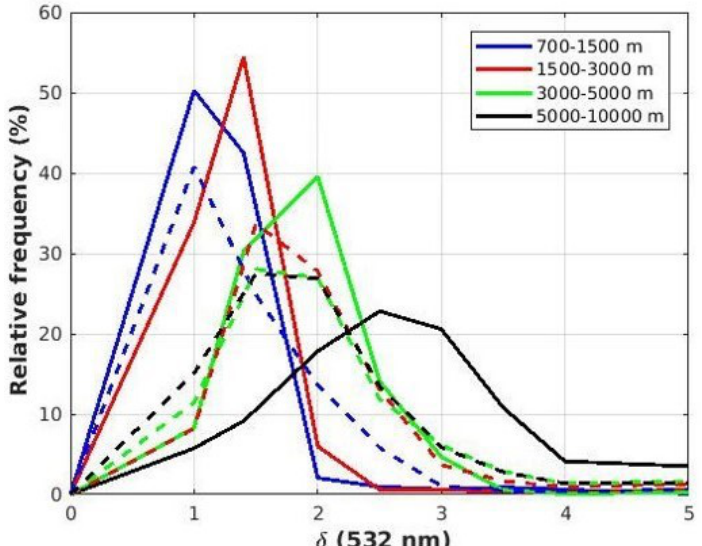
Figure 17. Comparing the depolarisation ratios from 1 to 13 of March 2018 (Müller [45]) in comparison to the data from this study (all available data from March 2019). The filled lines (in italic ) represent the 2018 data, while the dashed lines represent the 2019 data (this